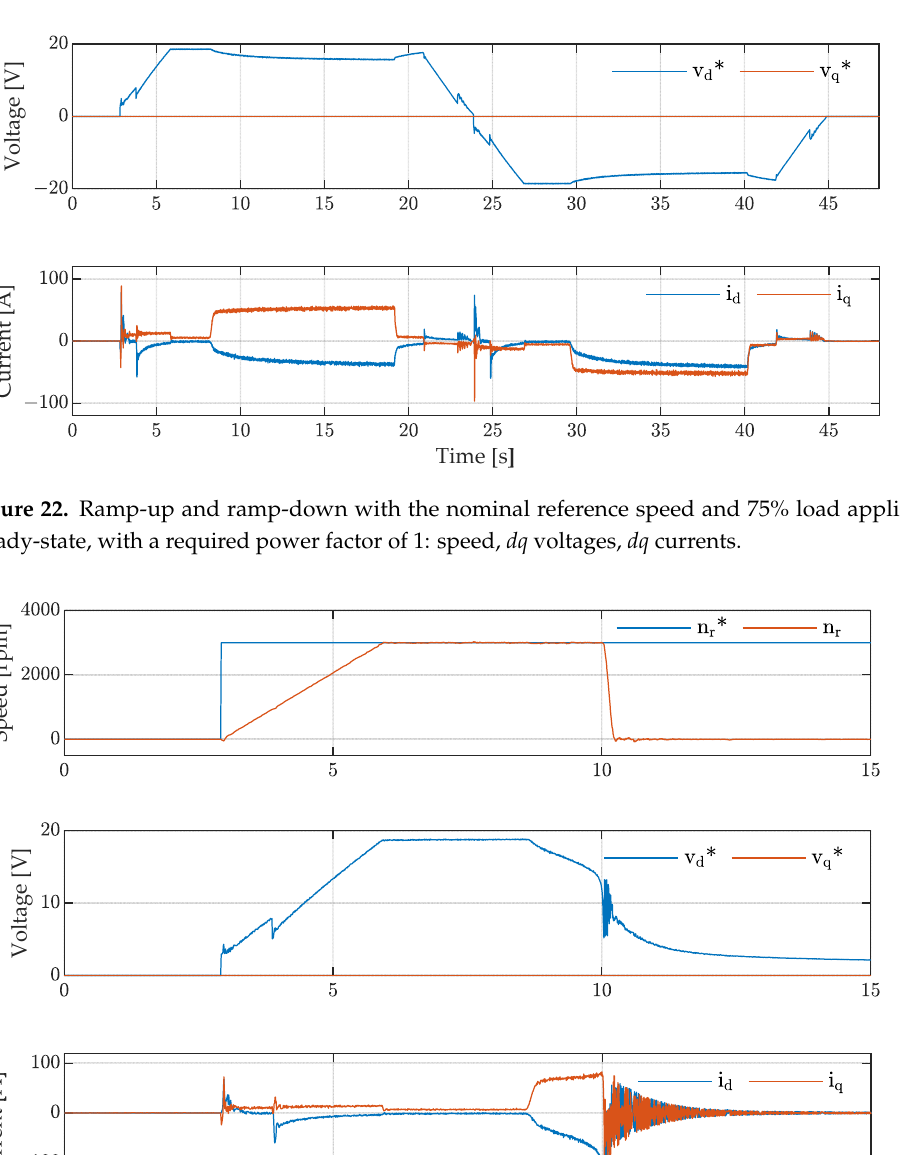
Figure 23. Ramp ‐ up with the nominal reference speed and 100% load applied at steady ‐ state, with Figure 23. Ramp-up with the nominal reference speed and 100% load applied at steady-state, with a required power factor of 1: speed, dq voltages, dq currents. a required power factor of 1: speed, dq voltages, dq